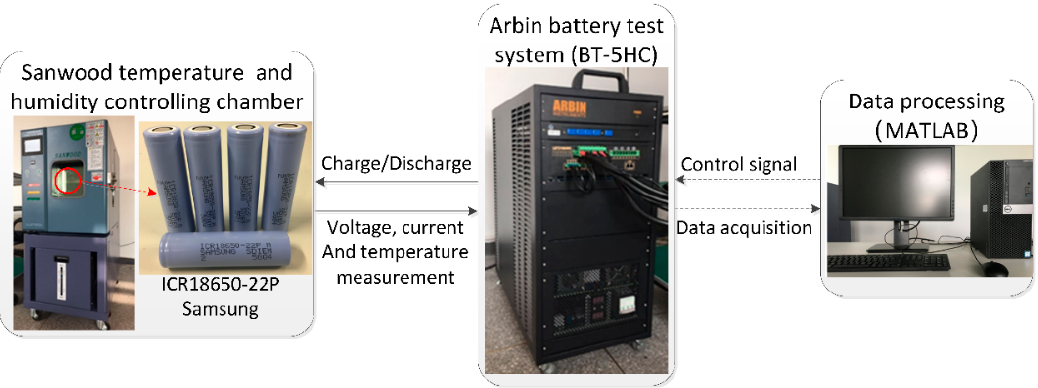
Figure 5. The experiment configuration.